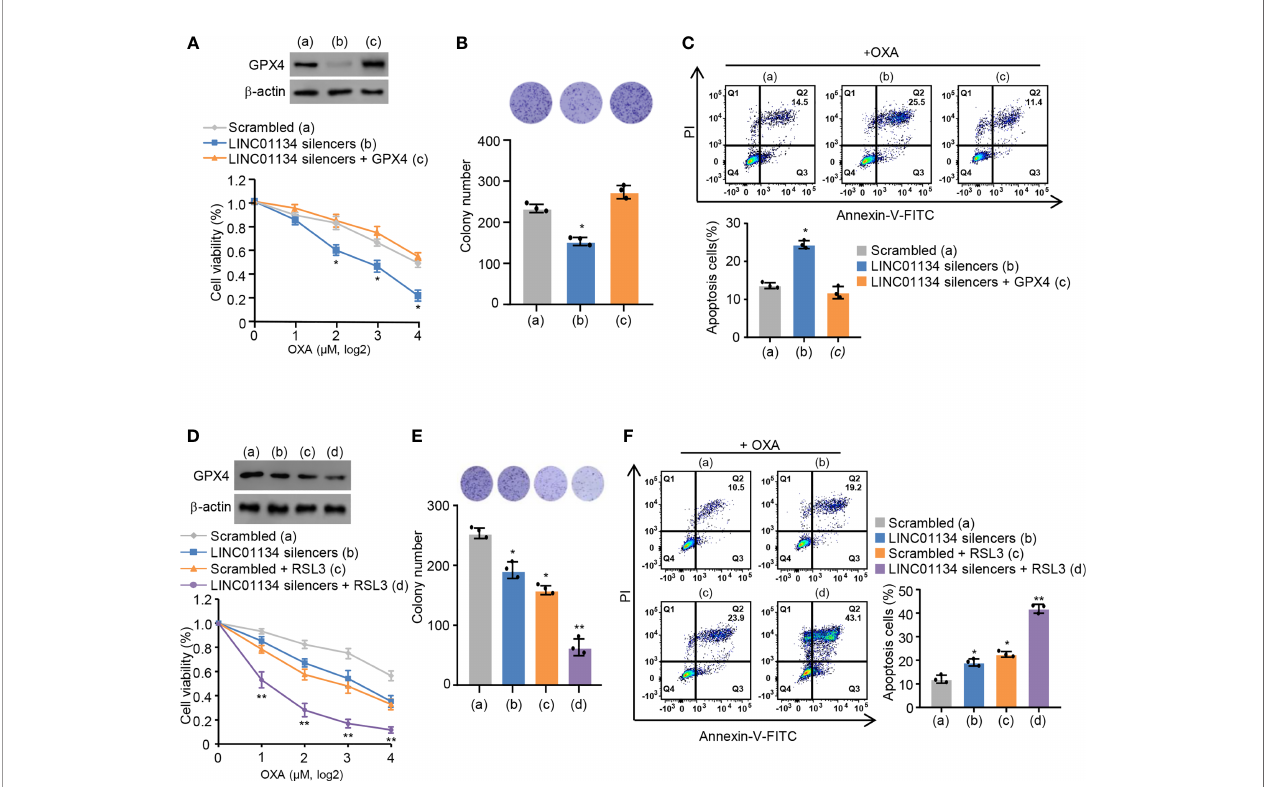
FIGURE 3 | Silenced LINC01134 enhances sensitivity of HCC OXA resistance through GPX4 pathway. (A) HepG2 cells were transfected with scrambled, LINC01134 silencers, or LINC01134 silencers plus pcDNA3.0-GPX4. Relative cell number was tested via CCK-8 assays. Representative immunoblot indicates GPX4 expression. (B) HepG2 cells were transfected with scrambled, LINC01134 silencers, or LINC01134 silencers plus pcDNA3.0-GPX4. Representative image of colony formation assay shows the colonies in dishes. The histogram indicates colony number. (C) Representative fl ow cytometry analysis of FITC/PI staining of (A) with OXA (8 m M, 3 days) re fl ects the cell death rate. (D) HepG2 cells were transfected with scrambled, LINC01134 silencers, with or without RSL3 treatment. Relative cell number was determined tested via CCK-8 assays. Representative immunoblot indicates GPX4 expression. (E) HepG2 cells were transfected with scrambled, LINC01134 silencers, with or without RSL3 treatment. Representative image of colony formation assay indicates the colonies in dishes. The histogram shows colony number. (F) Representative fl ow cytometry analysis of FITC/PI staining of (C) with OXA (8 mM, 3 days) indicates the cell death rate. Data are shown as the mean ± SEM; n ≥ 3 independent experiments, two-tailed Student ’ s t-test: *P < 0.05, **P <